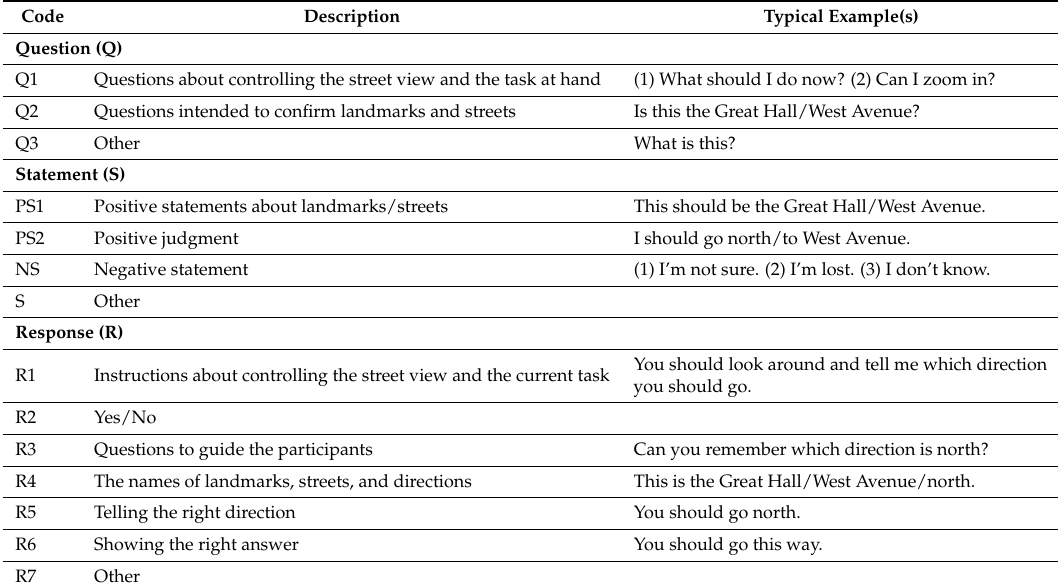
Table 1. Code scheme of the dialogue between participants and